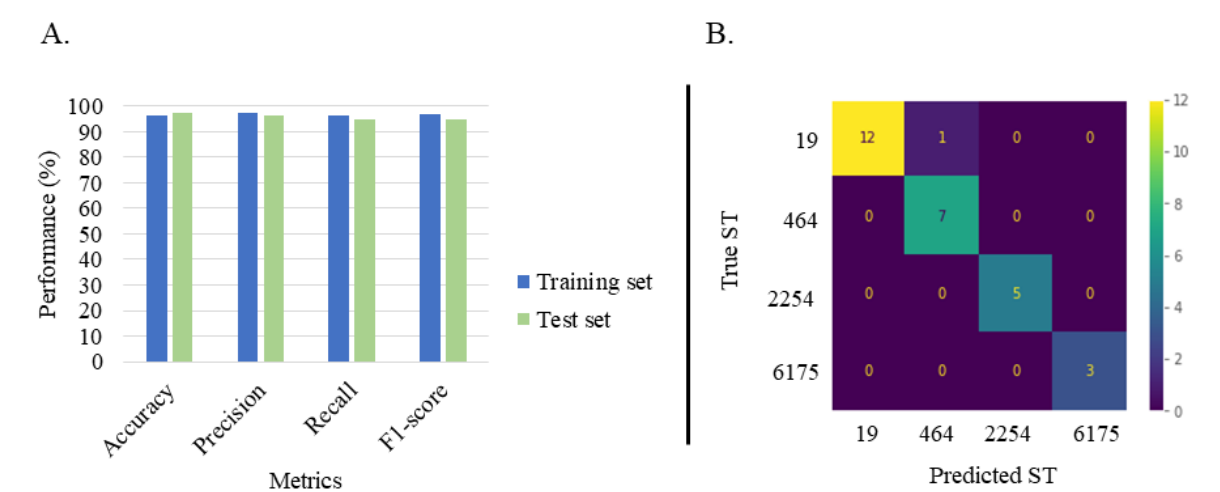
Figure 2. ( A ): Performance metrics for the random forest classifier for both training and test dataset. The horizontal axis was the four metrics balanced accuracy, precision, recall and F1-score, which were averaged over 10-fold cross validations. ( B ): Confusion matrix obtained for the classification of the test set using the trained random forest classifier.